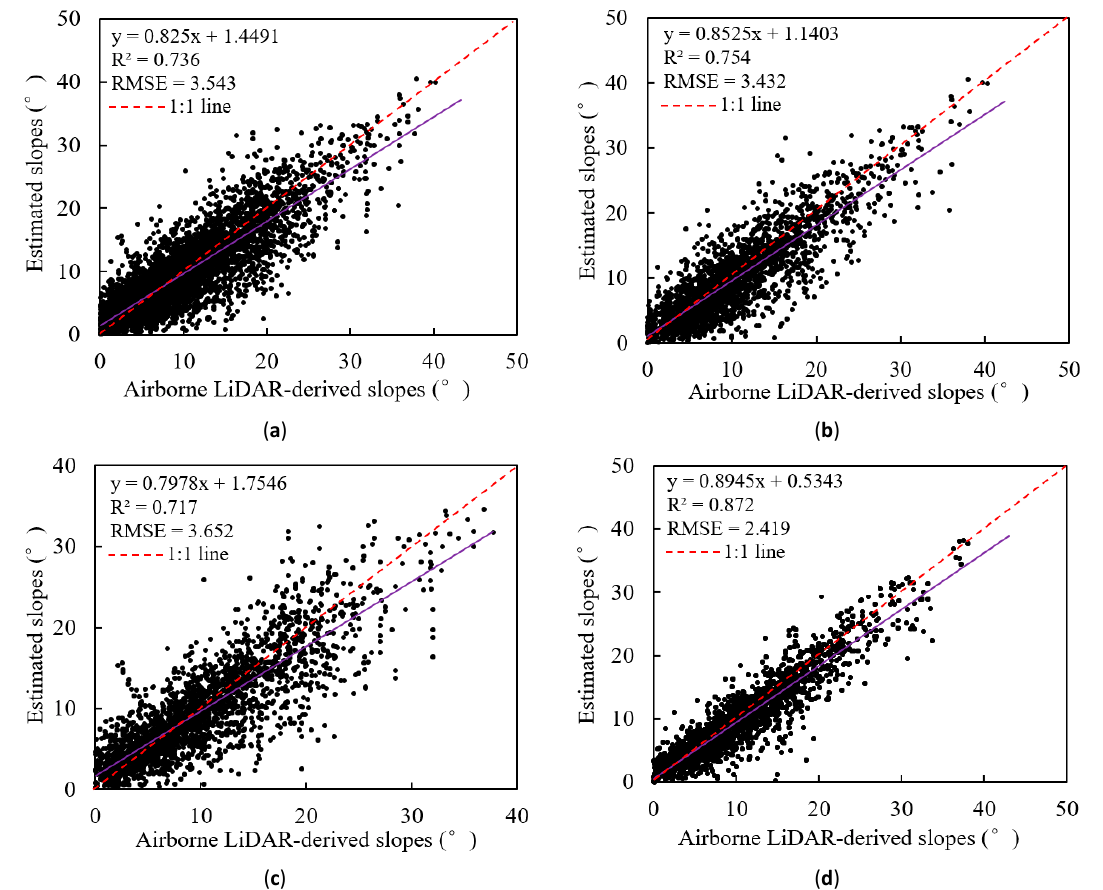
Figure 6. The scatterplots of airborne LiDAR-derived slopes versus estimated slopes using different